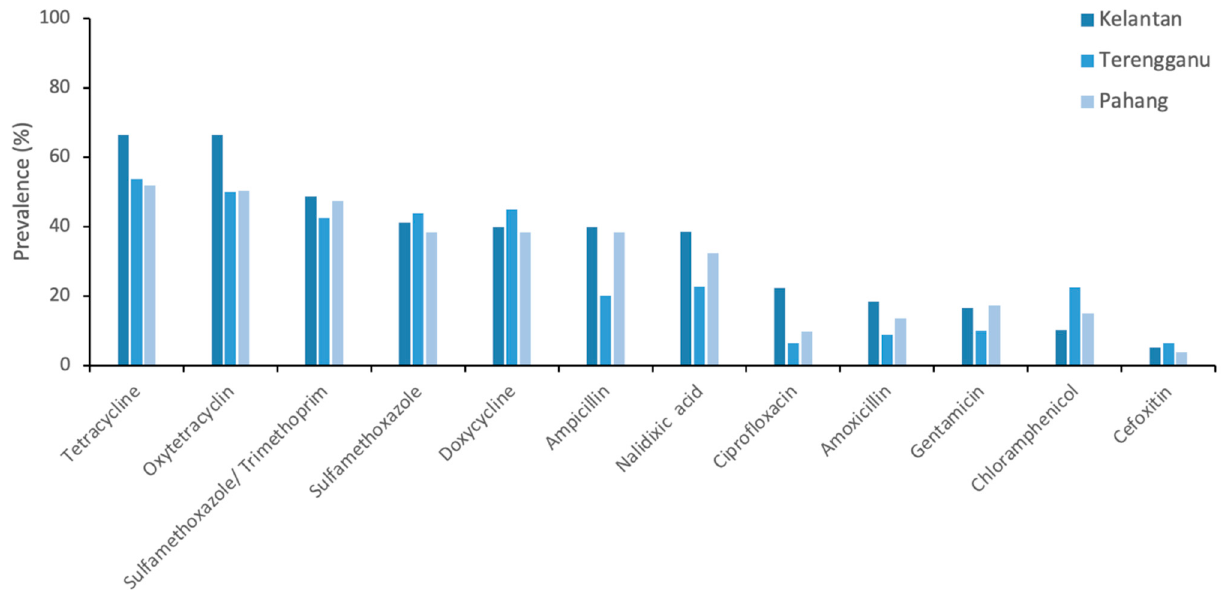
Figure 2. Prevalence of antimicrobial-resistant Escherichia coli isolated from poultry farms collected from Kelantan, Terengganu, and Pahang poultry operations. Data are the number of samples (n = 371).